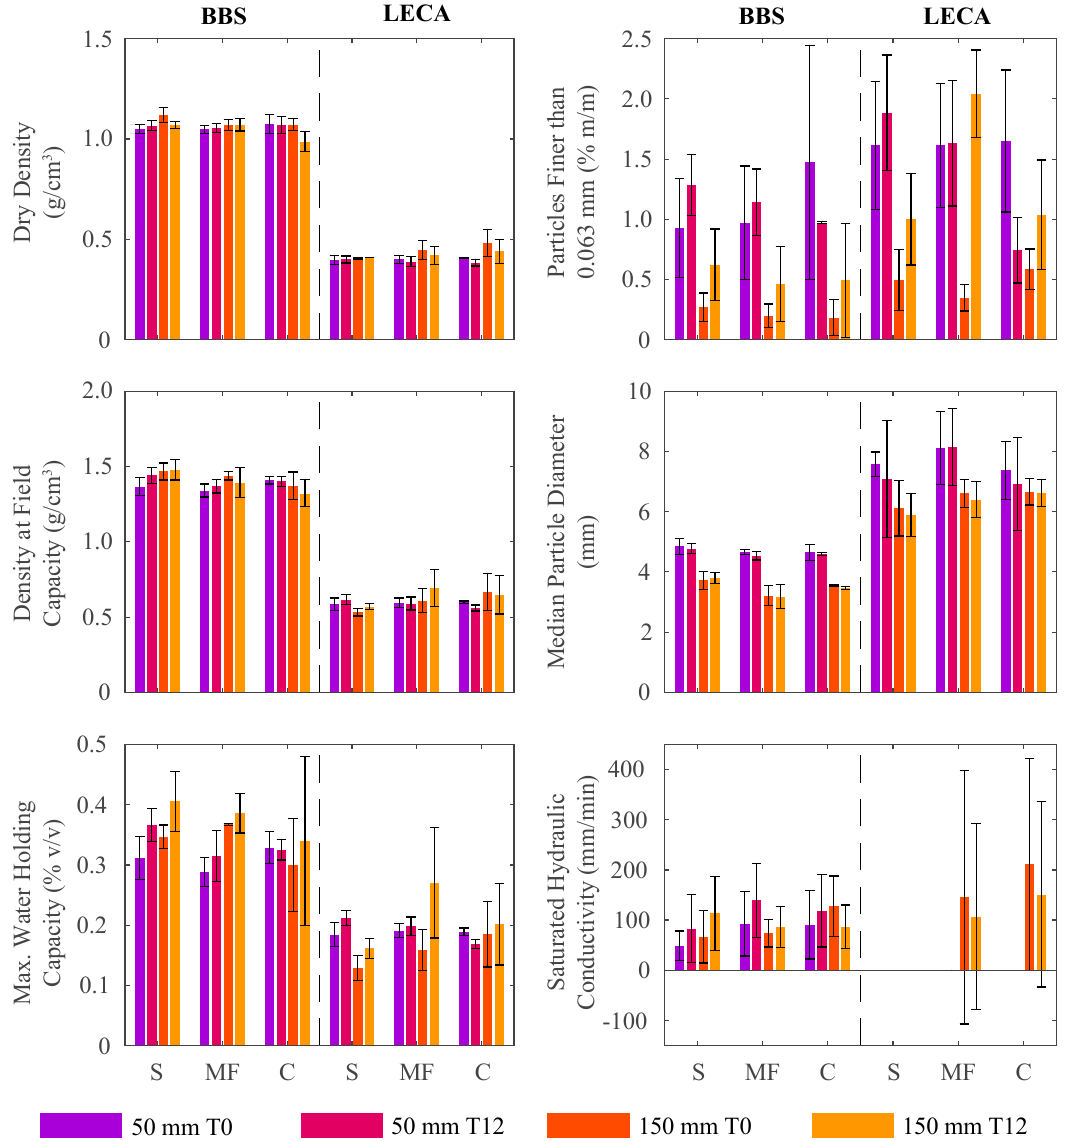
Figure 3. Comparison of physically derived properties at the beginning (T0) and end (T12) of the 12-month study period for both 50 mm and 150 mm diameter microcosms. Error bars indicate ±1 standard deviations. S —Sedum. MF —Meadow Flower. C —Control.